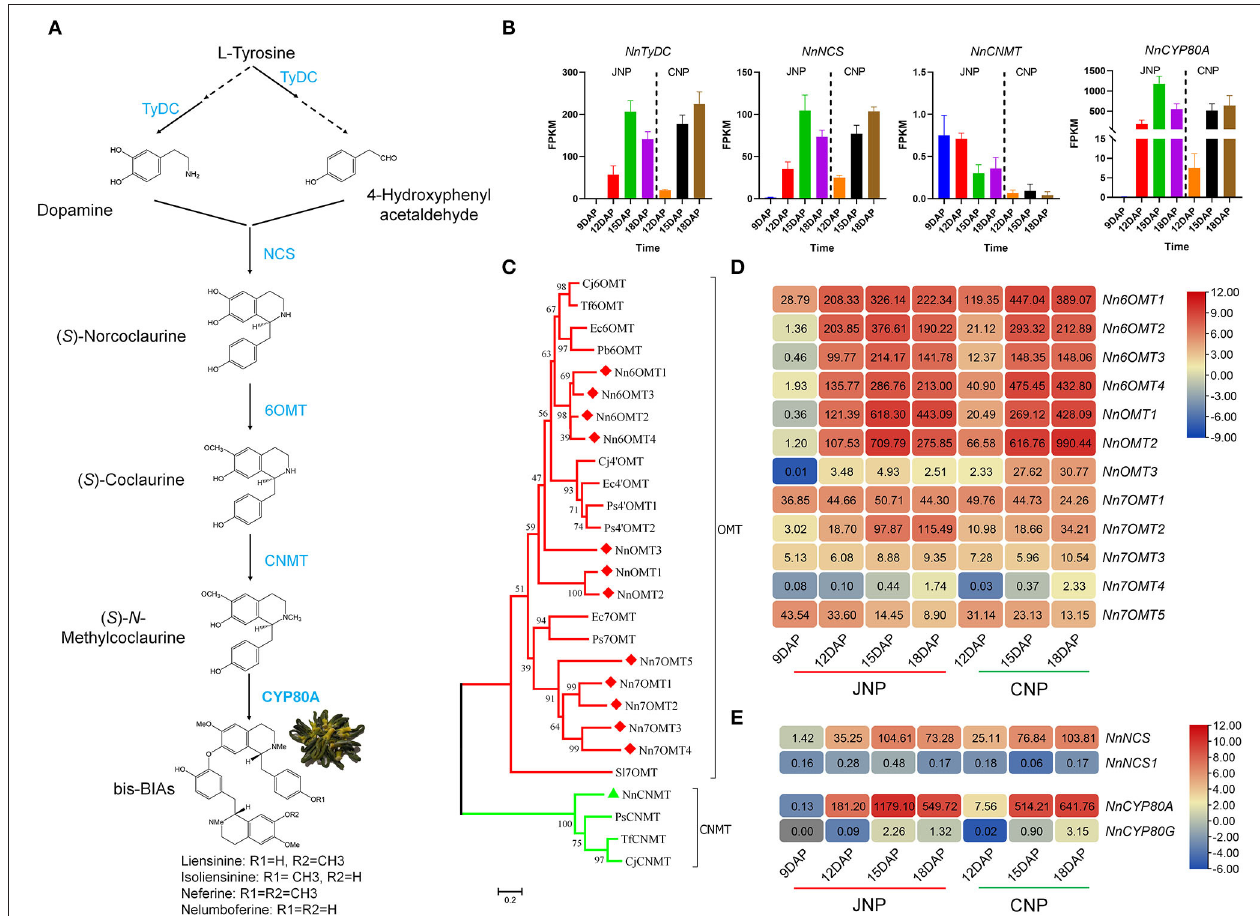
FIGURE 3 | Identification and expression analysis of bis-BIAs biosynthesis genes. (A) Key steps in the predicted bis-BIAs biosynthesis pathway in lotus plumule. (B) Expression patterns of NnTyDC (NNU_22559), NnNCS (NNU_14334), NnCNMT (NNU_11880), and NnCYP80A (NNU_21373) during lotus plumule development. (C) Phylogenetic tree depicting the relationship between differentially expressed O -methyltransferase (OMT) genes. GenBank Accession Number: Cj6OMT (BAB08004.1), Tf6OMT (ACO90238.1), Ec6OMT (BAM37634.1), Pb6OMT (ACO90225.1), Cj4’OMT (Q9LEL5.1), Ec4’OMT (BAM37633.1), Ps4’OMT1 (XP_026430708.1), Ps4’OMT2 (XP_026440860.1), Ec7OMT (BAE79723.1), Ps7OMT (XP_026440002), PsCNMT (Q7XB08.1), TfCNMT (Q5C9L6.1), and CjCNMT (BAB71802.1). (D) Expression patterns of OMT genes during lotus plumule development. (E) A heatmap showing expression differences between NnNCS and NnCYP80 homolog